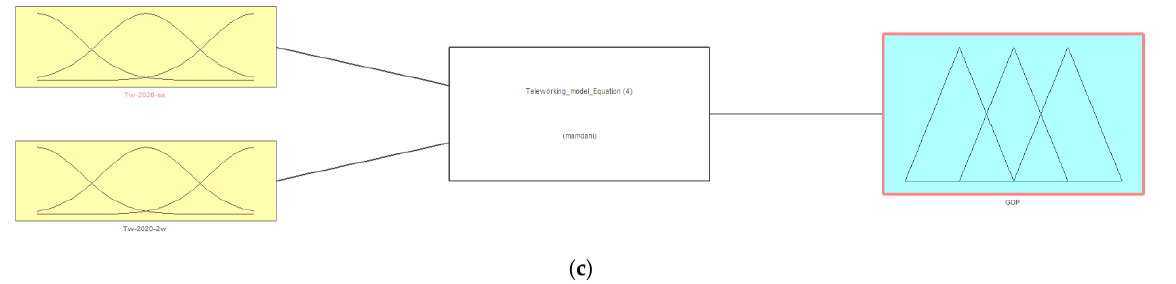
Figure 4. Fuzzy inference systems diagrams ( a – c ) for GDP growth probability distribution under the influence of teleworking assessment models. ( a ) FIS Model 1 based on Equation (5); ( b ) FIS Model 2 based on Equation (3); ( c ) FIS Model 3 based on Equation (4).